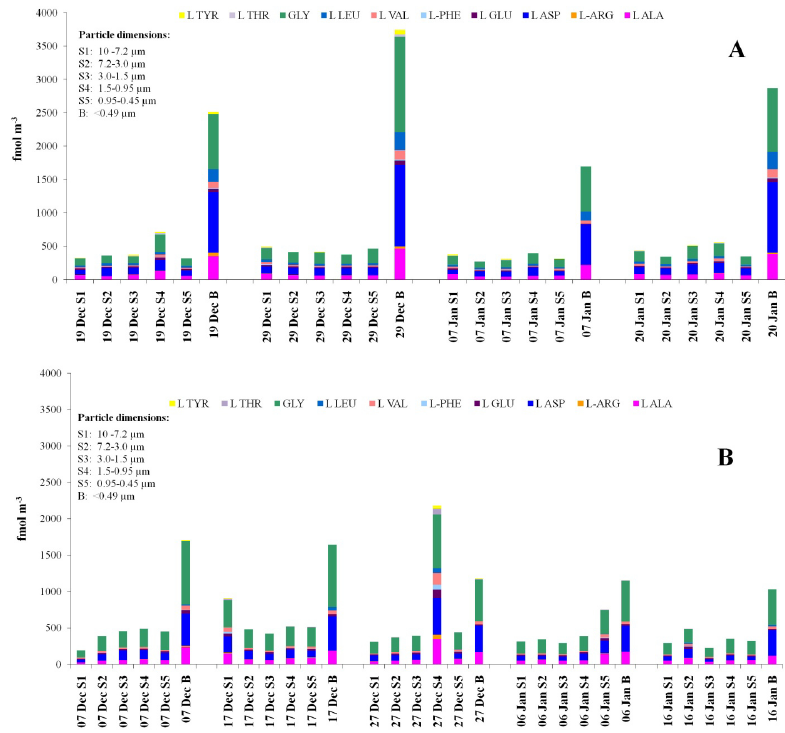
Figure 5. Size distributions of amino acid concentrations in the samples collected during the summer of 2011–2012 (a) and during the summer of 2012–2013 (b) at the Italian–French base “Concordia Station” (Dome